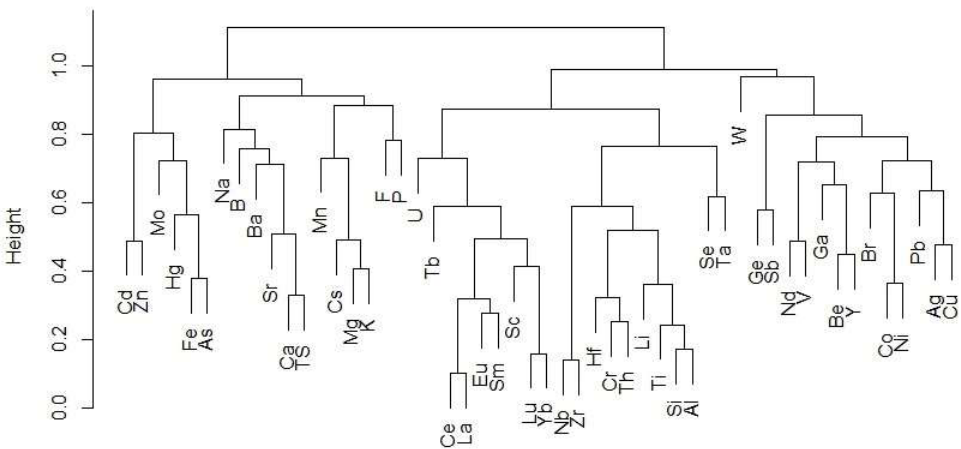
Figure 6. Dendrogram depicting results of agglomerative hierarchical clustering of coal chemistry data.